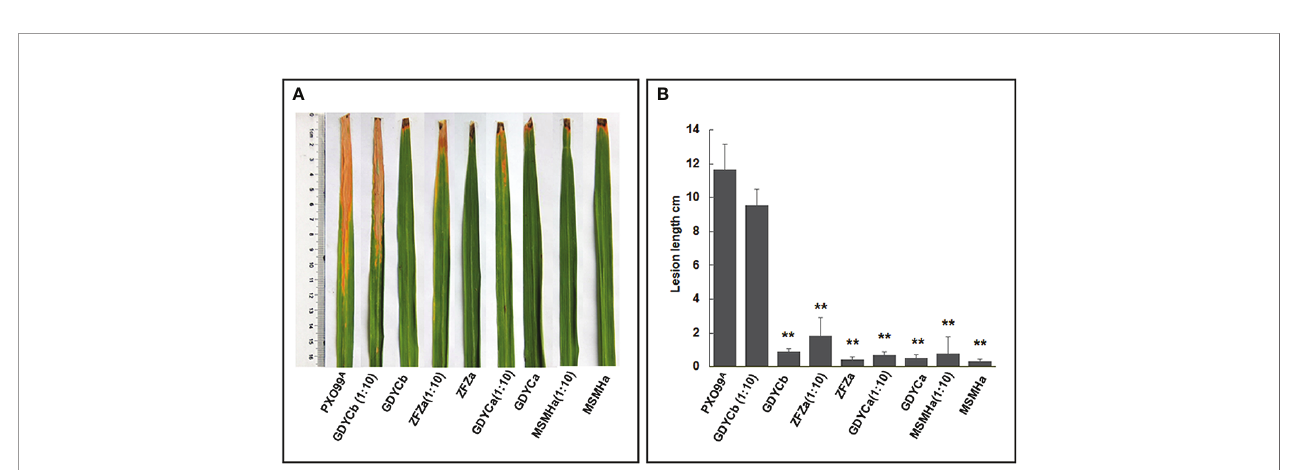
FIGURE 5 | In-planta BB suppression assays. (A) Each leaf was inoculated with Xoo PXO99 A , Pantoea sp. isolates, Curtobacterium sp. isolate, the mixture of Pantoea sp. isolate or Curtobacterium sp. Isolate, and Xoo PXO99 A at 1:10 ratio using the leaf clipping method. BB symptoms were observed on the 14th day after inoculation. (B) The length of the disease lesion on each leaf. The error bar represents standard deviation of the lesion lengths recorded from ≥ 10 leaves. ** indicates p < 0.01 by